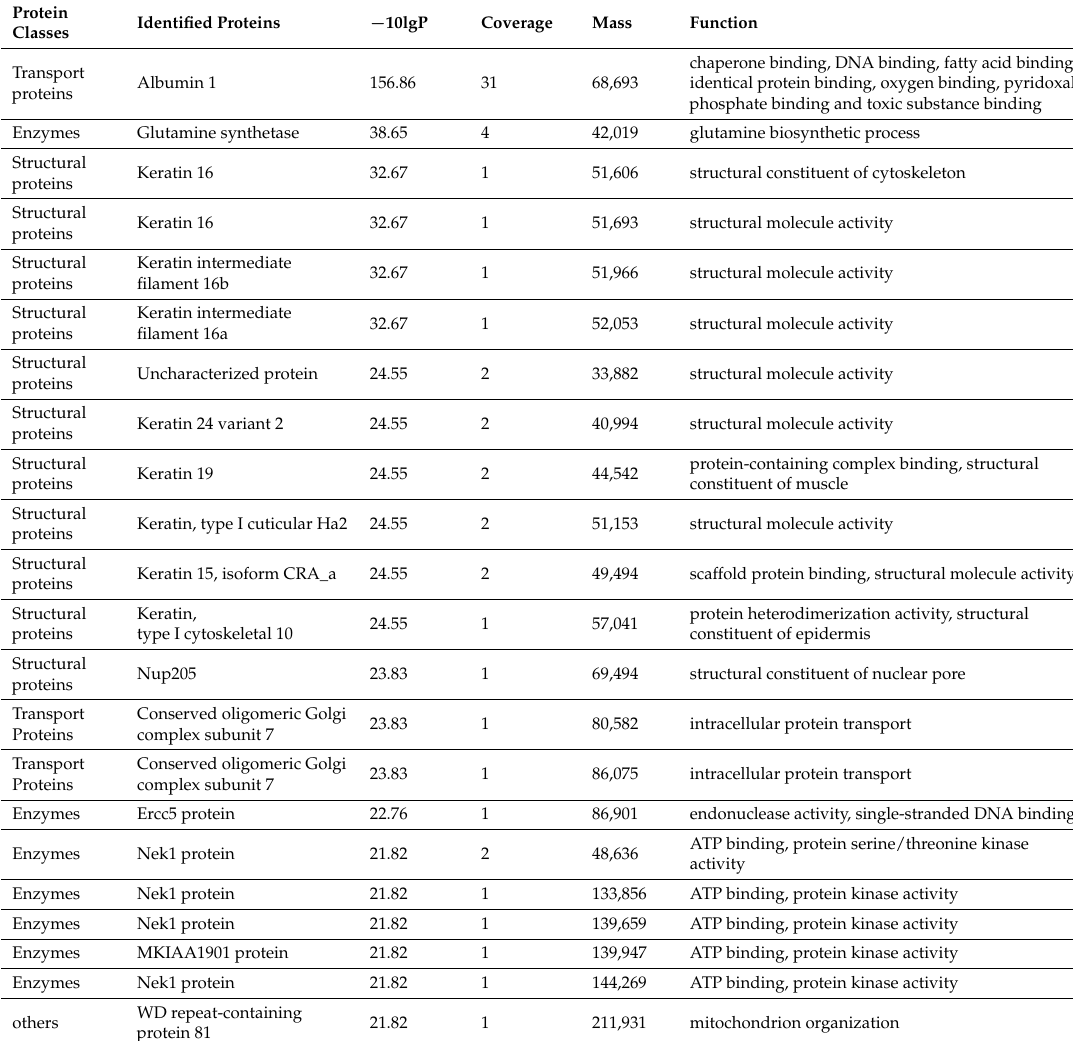
Table 1. Proteins bound with SSNs in the presence of 10% of mice